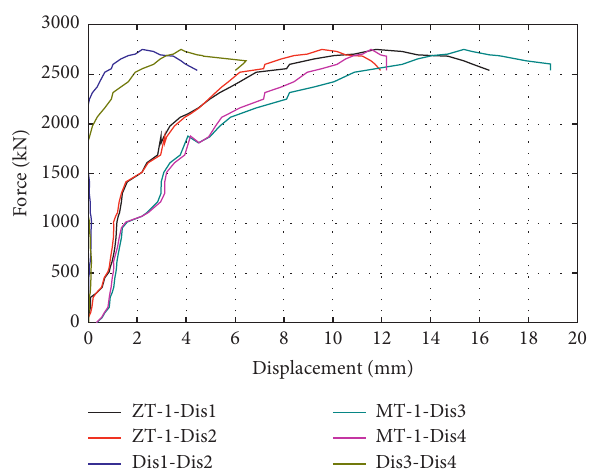
Figure 26: Load-slip diagram.